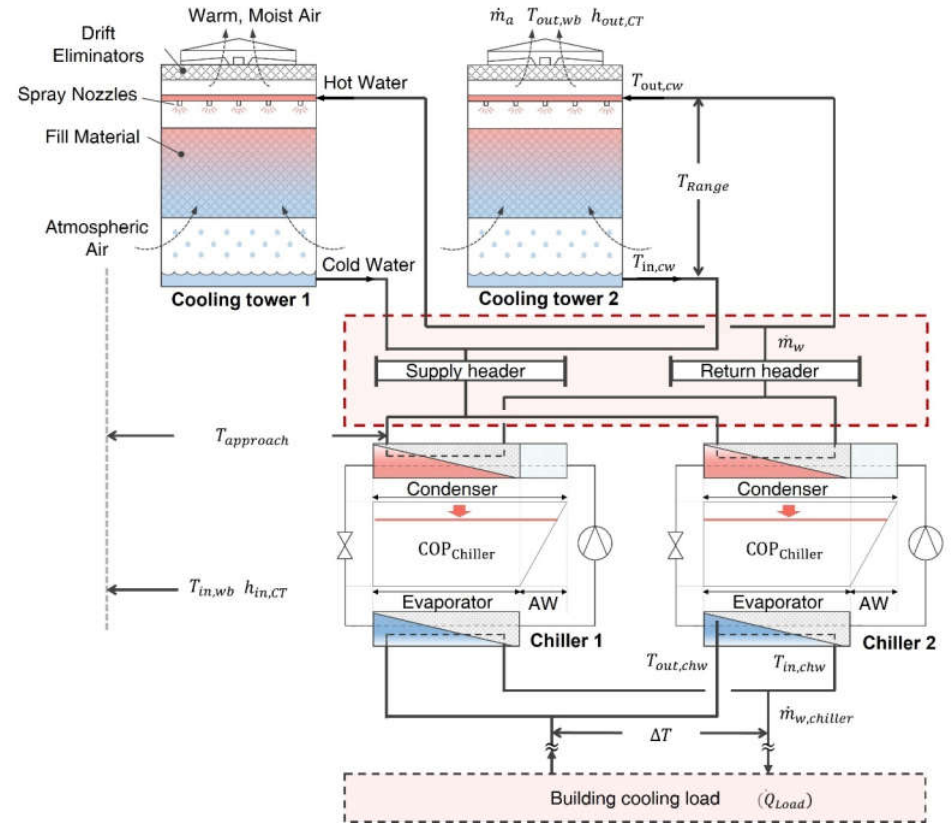
Figure 6. Integrated cooling tower (Case E). Table 1. Data exchange between EnergyPlus and